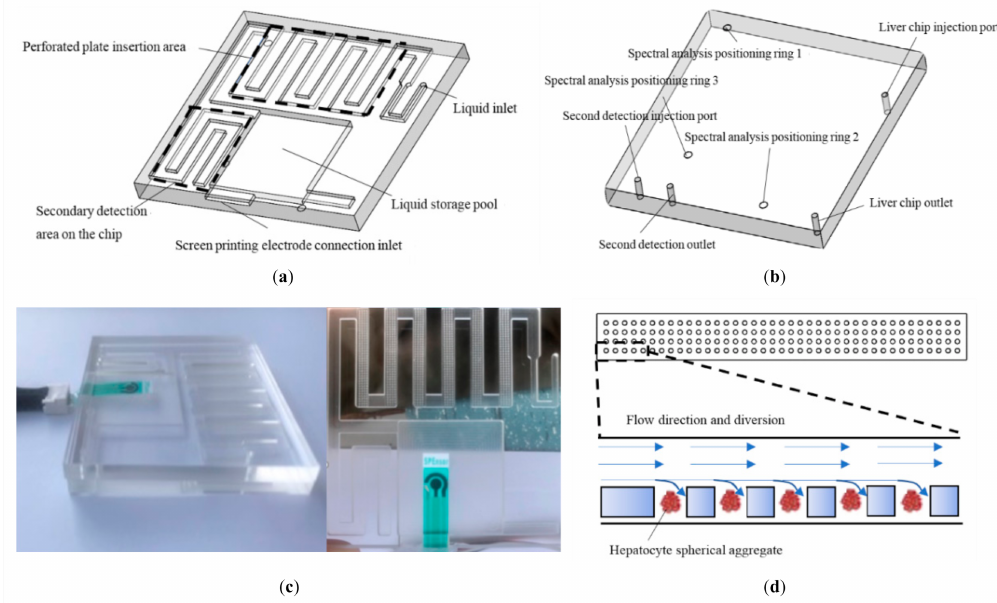
Figure 1. View of each part of the liver chip: ( a ) schematic diagram of the lower liver chip; ( b ) schematic diagram of the upper liver chip; ( c ) fabricated liver on a chip; and ( d ) porous pad and its schematic diagram of